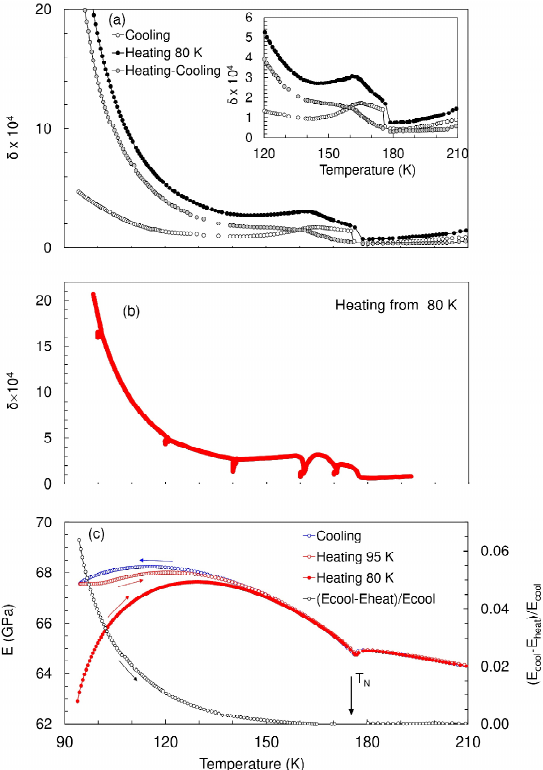
Fig. 3. T emperature spectra of the internal friction,  , (a, b) and Young´s modulus, E , (c) in a continu- ous (a, c) and interrupted for 40 min of isothermal dwelling (b) temperature cycle 210-80-210K. The differences between the values of internal friction (a) and Young´s modulus (c) on heating and cooling are shown. Panel (c) shows also the Young´s modu- lus in a temperature cycle 210-95-210K. Oscilla- tory strain amplitude  = 10 -5 0